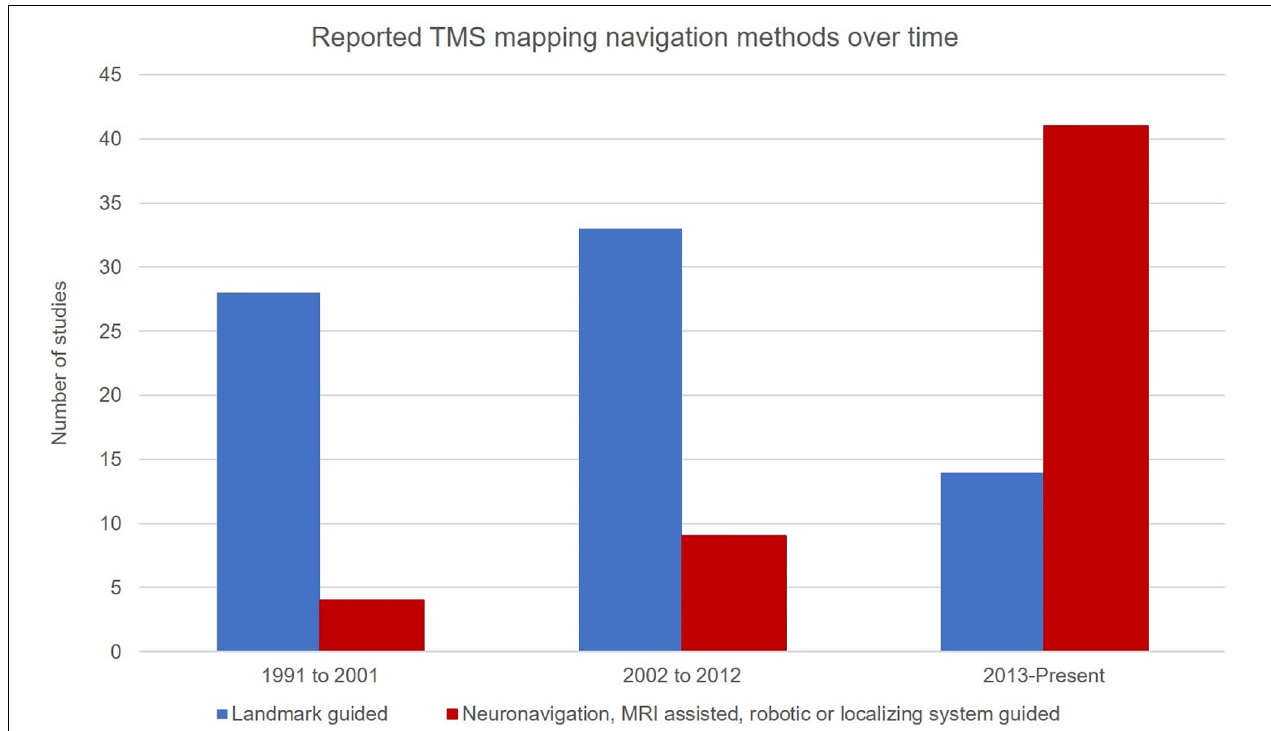
FIGURE 2 | Studies reporting a particular navigation method by decade. Suggestive of a shift away from the use of landmark guided navigation (blue) in favor of neuronavigated methods and its subtypes